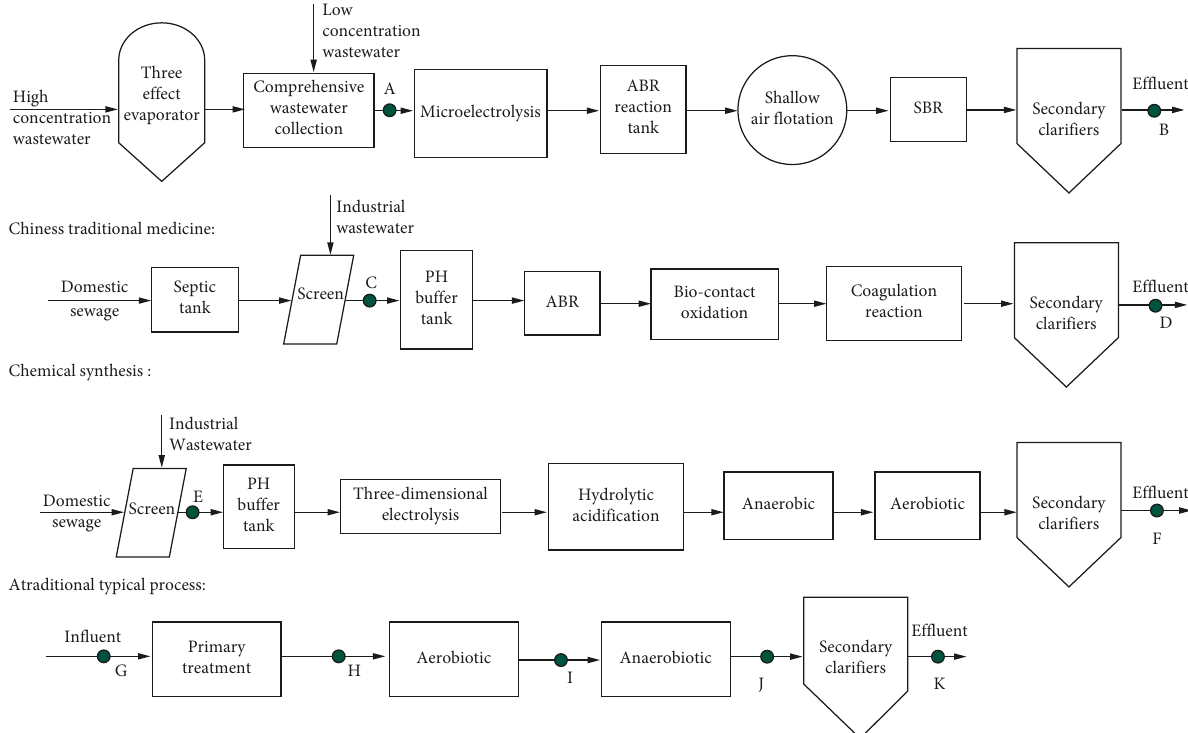
Figure 1: Schematic diagram of the treatment processes at three typical pharmaceutical wastewater treatment plants and the traditional typical